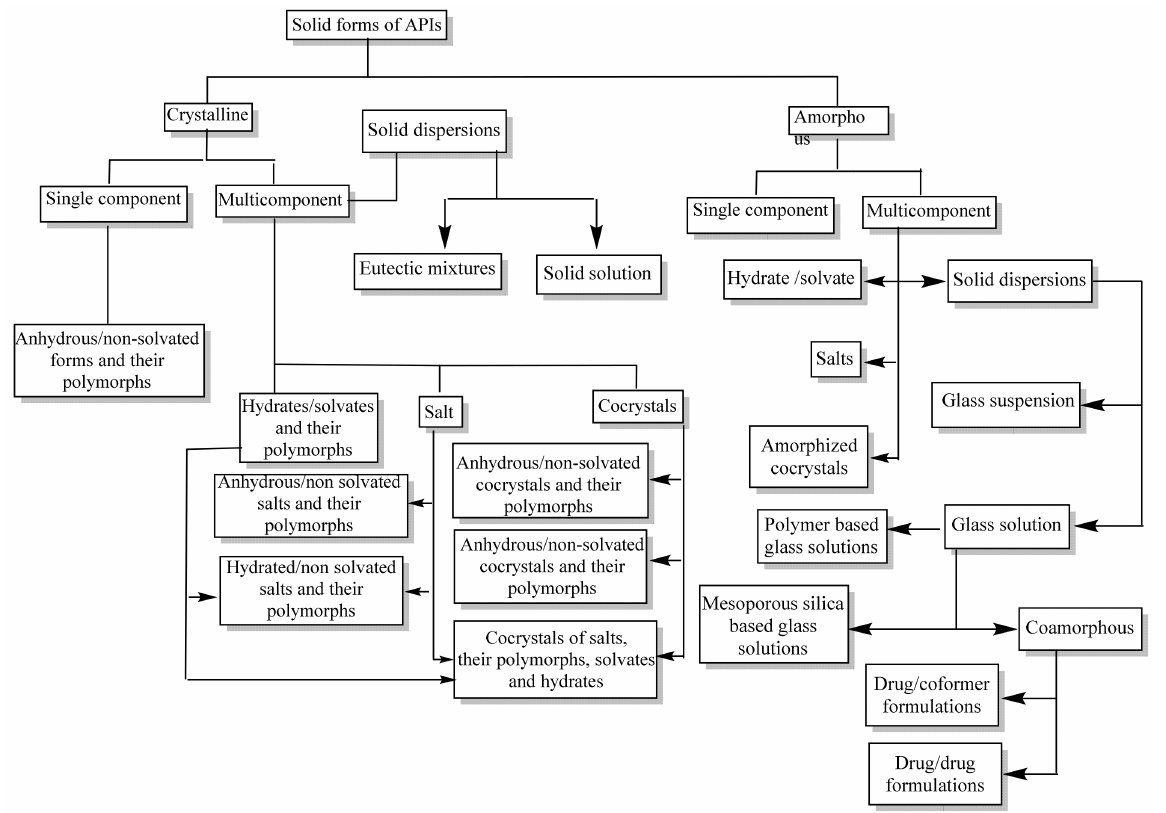
Figure 1. Classification of an API depending on its scale range-order periodicity and composition. Adapted with permission from [15], Elsevier,